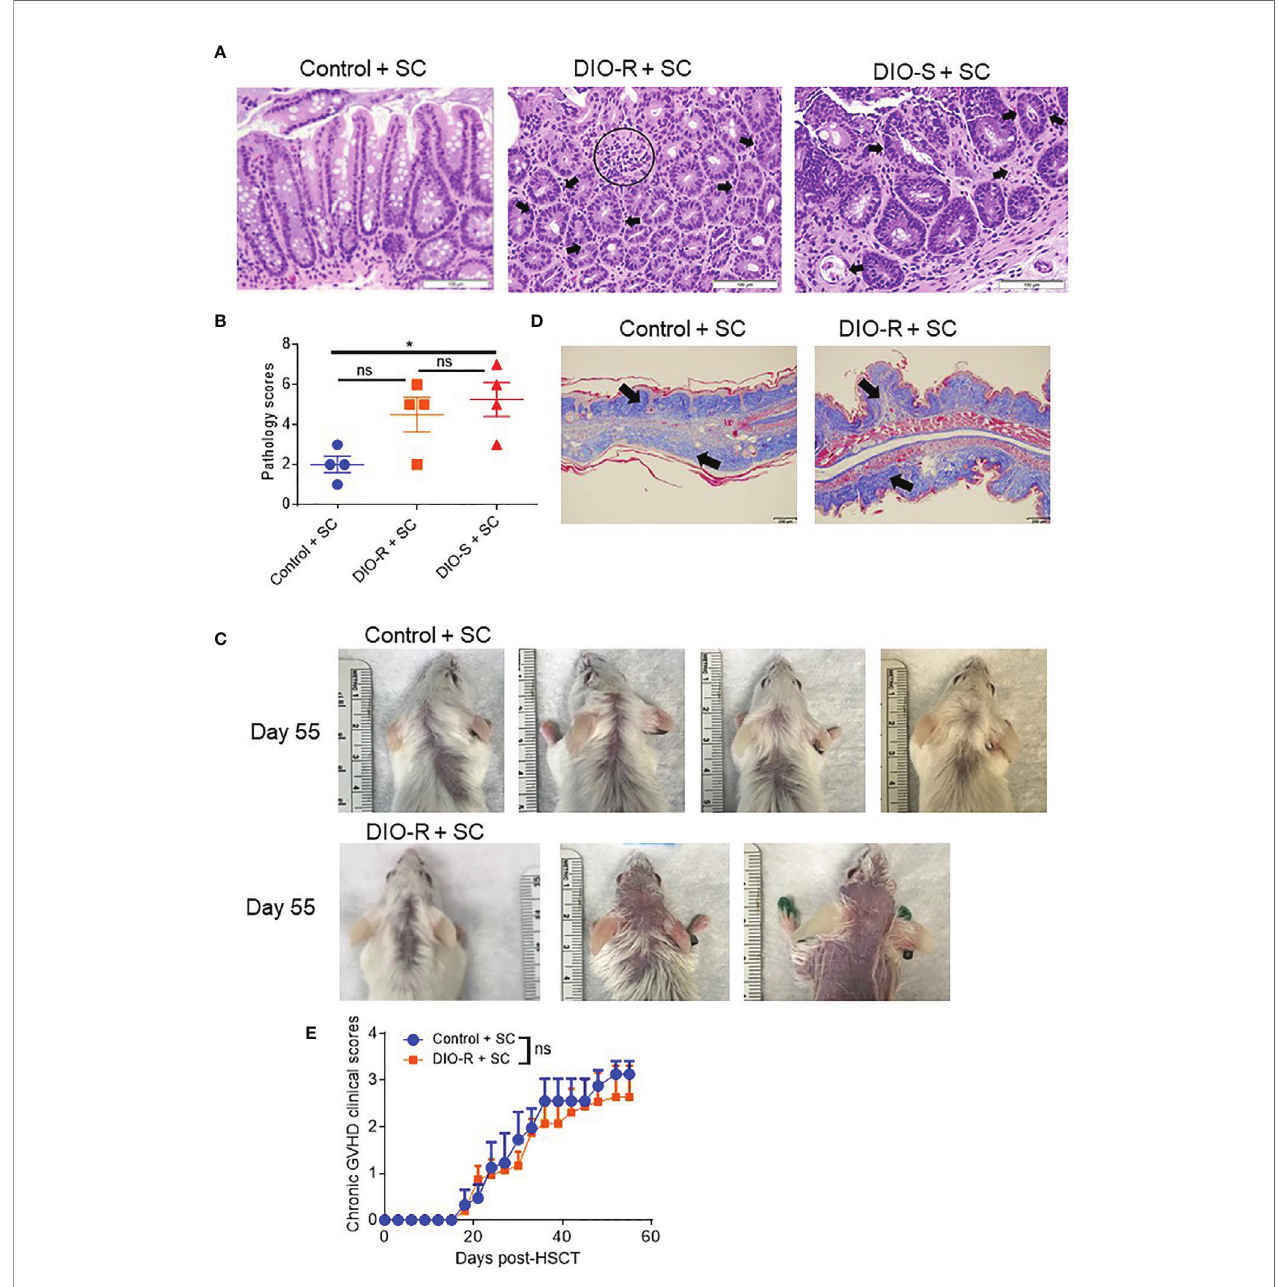
FIGURE 2 | (A) Representative images of H&E staining from colon samples at day 7 post-HSCT. The scale bar is 100 m m. Circle indicates severe goblet cell loss and mild, multifocal lamina proprial in fl ammation. Arrows indicate piling of glandular epithelial cells, degenerate crypts, apoptotic crypt abscess and rare karyomegalic cells. (B) Pathology scores of samples from (A) (n=4/group). (C) Representative images of sclerodermatous GVHD with alopecia at day 55 post-HSCT. (D) Representative photos of sclerodermatous GVHD with tissue fi brosis by Trichrome staining. The scale bar is 200 m m. Arrows indicate collagen deposition (blue). (E) Chronic GVHD clinical scores post-HSCT (n=3-4/group). Bar graphs depict mean ±s.e.m. One-way ANOVA test was used in (B) . Unpaired Student ’ s t test was used in (E) . *p < 0.05, NS, not signi fi